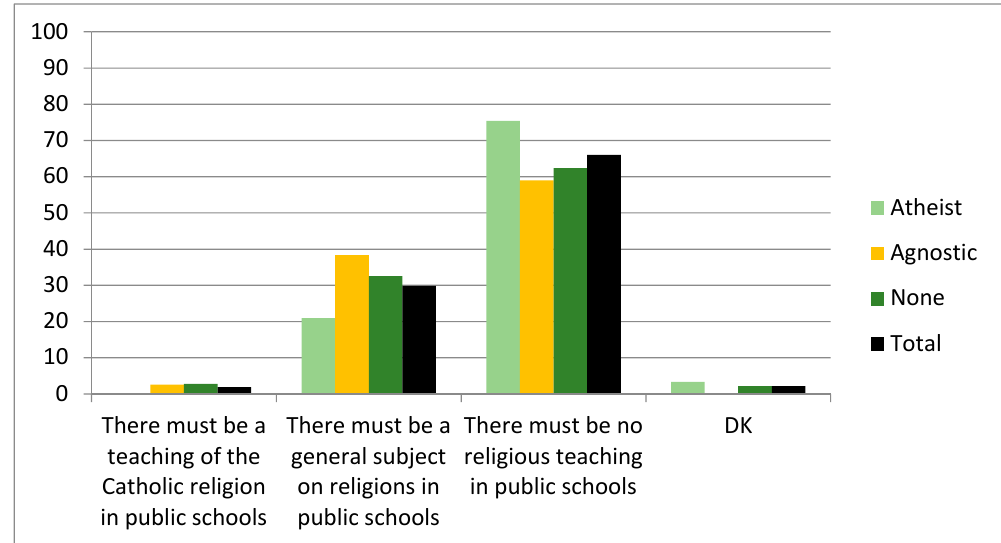
Figure 10. Opinion on religious education in public schools (in %). Based on 382 cases. Source: Author’s elaboration based on the Second National Survey on Religious Beliefs and Attitudes. Society, Culture and Religion Program, CEIL-CONICET, 2019.